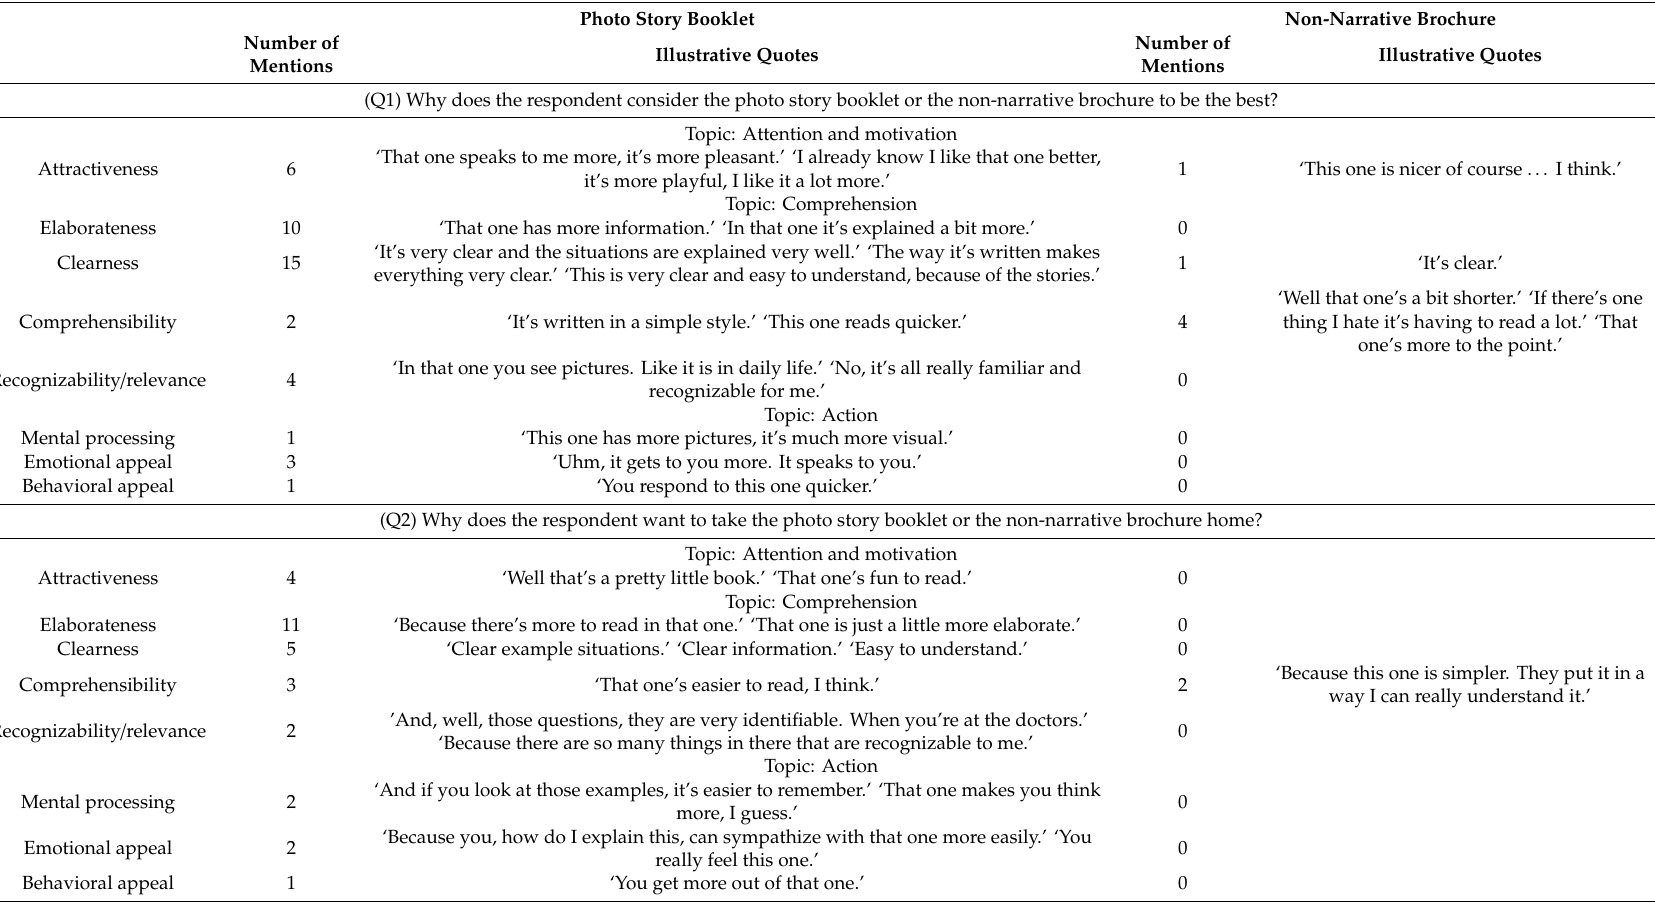
Table 5. Explanations for preference grouped according to factors related to attention and motivation, comprehension and